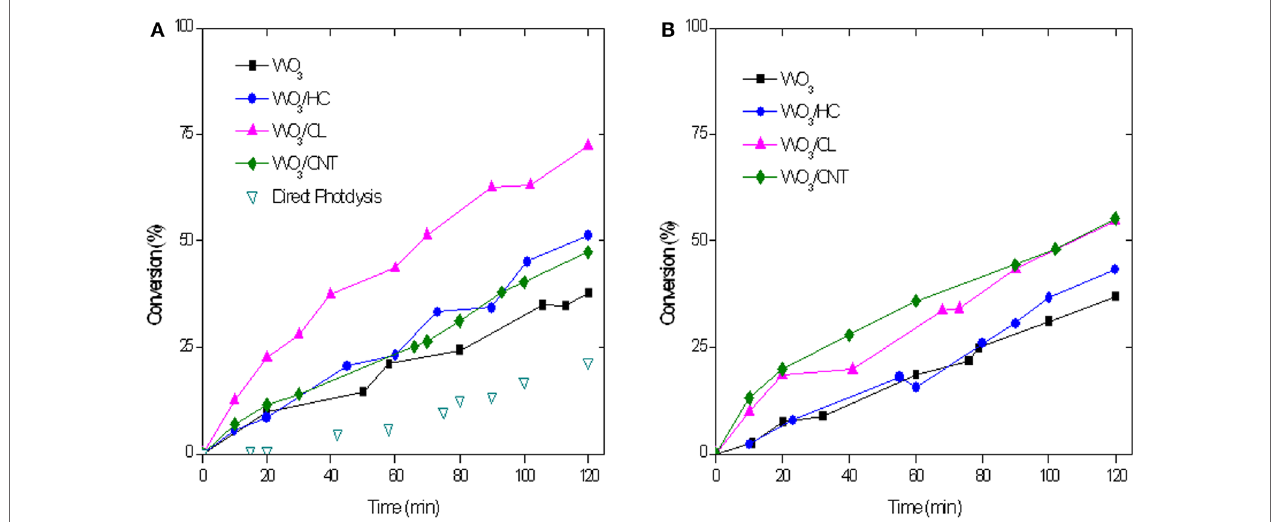
FigUre 8 | rhB conversion with a catalyst loading of 0.5 g/l (a) and 1 g/l (B) upon simulated solar light irradiation of the catalysts . Five milligram per liter rhodamine B in solution at the beginning of the